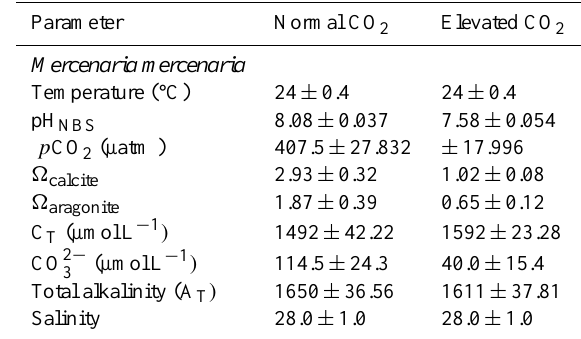
Table 4. Temperature, pH, carbonate chemistry, total alkalinity, and salinity (±1SD) during the two-level carbon dioxide varying expo- sure experiment with Argopecten irradians larvae.